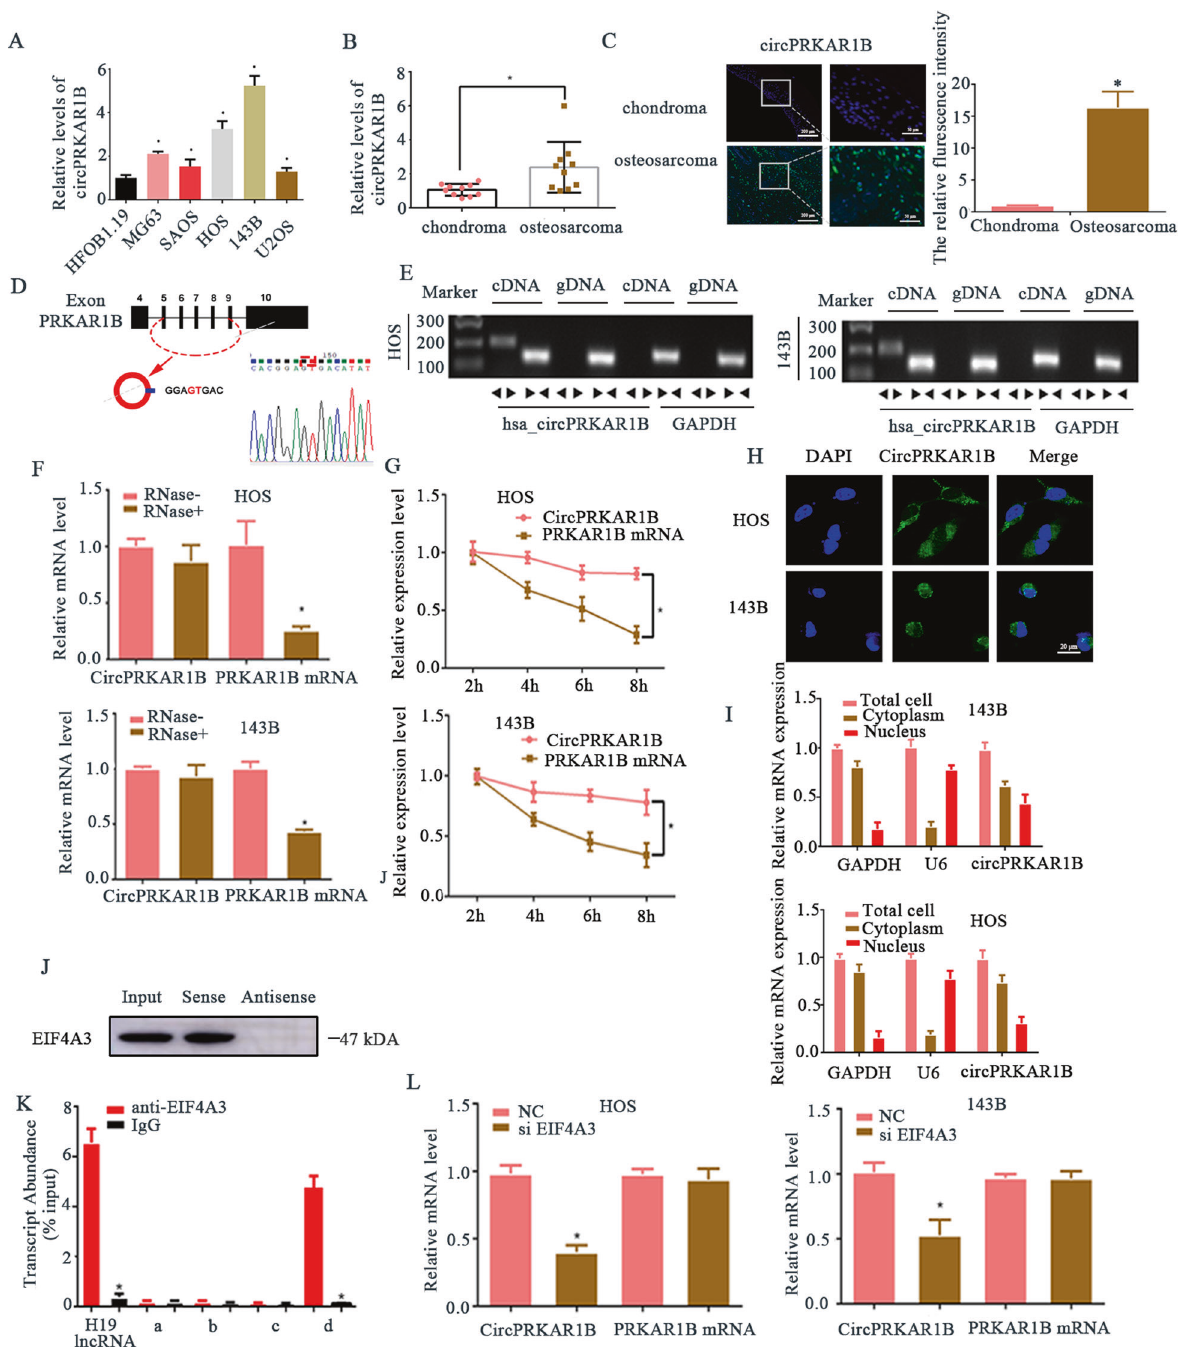
Fig. 1 Validation and expression of circPRKAR1B in OS tissues and cells. A Expression of circPRKAR1B in OS cell lines compared with control cells (HFOB1.19 cells). B The level of circPRKAR1B was higher in human OS tissue samples than chondroma samples. C FISH showed that circPRKAR1B expression was higher in OS tissues than chondroma tissues. D Schematic diagram illustrating that exons 5 – 9 of PRKAR1B form circPRKAR1B. E Agarose gel electrophoresis showing the presence of circPRKAR1B in HOS and 143B cells by RT-PCR. Divergent primers ampli fi ed circPRKAR1B from cDNA but not from genomic DNA. GAPDH was used as a negative control. F The expression of circPRKAR1B and PRKAR1B mRNA in HOS and 143B cells treated with or without RNase R, as determined by RT-qPCR. G The levels of circPRKAR1B and PRKAR1B in HOS and 143B cells treated with actinomycin D at the indicated time points were measured by RT-qPCR. H FISH revealed that circPRKAR1B was predominantly localised in the cytoplasm. Nuclei were stained with DAPI, and circPRKAR1B probes were labelled with Alexa Fluor 488. I qRT-PCR was performed to determine the main localisation of circPRKAR1B in OS cells. J Western blotting were used to demonstrate the interaction between EIF4A3 and the circPRKAR1B downstream region. K RIP was performed to verify that eIF4A3 binds PRKAR1B mRNA. H19 lncRNA was used as the positive control, and RT-qPCR was used to measure transcript levels relative to the input. L HOS and 143B cells were transfected with control or a plasmid to knock down eIF4A3, and circPRKAR1B expression was measured by RT-qPCR. Scale bar = 20 μ m. The data represent the mean ± SD of three independent experiments (* P <